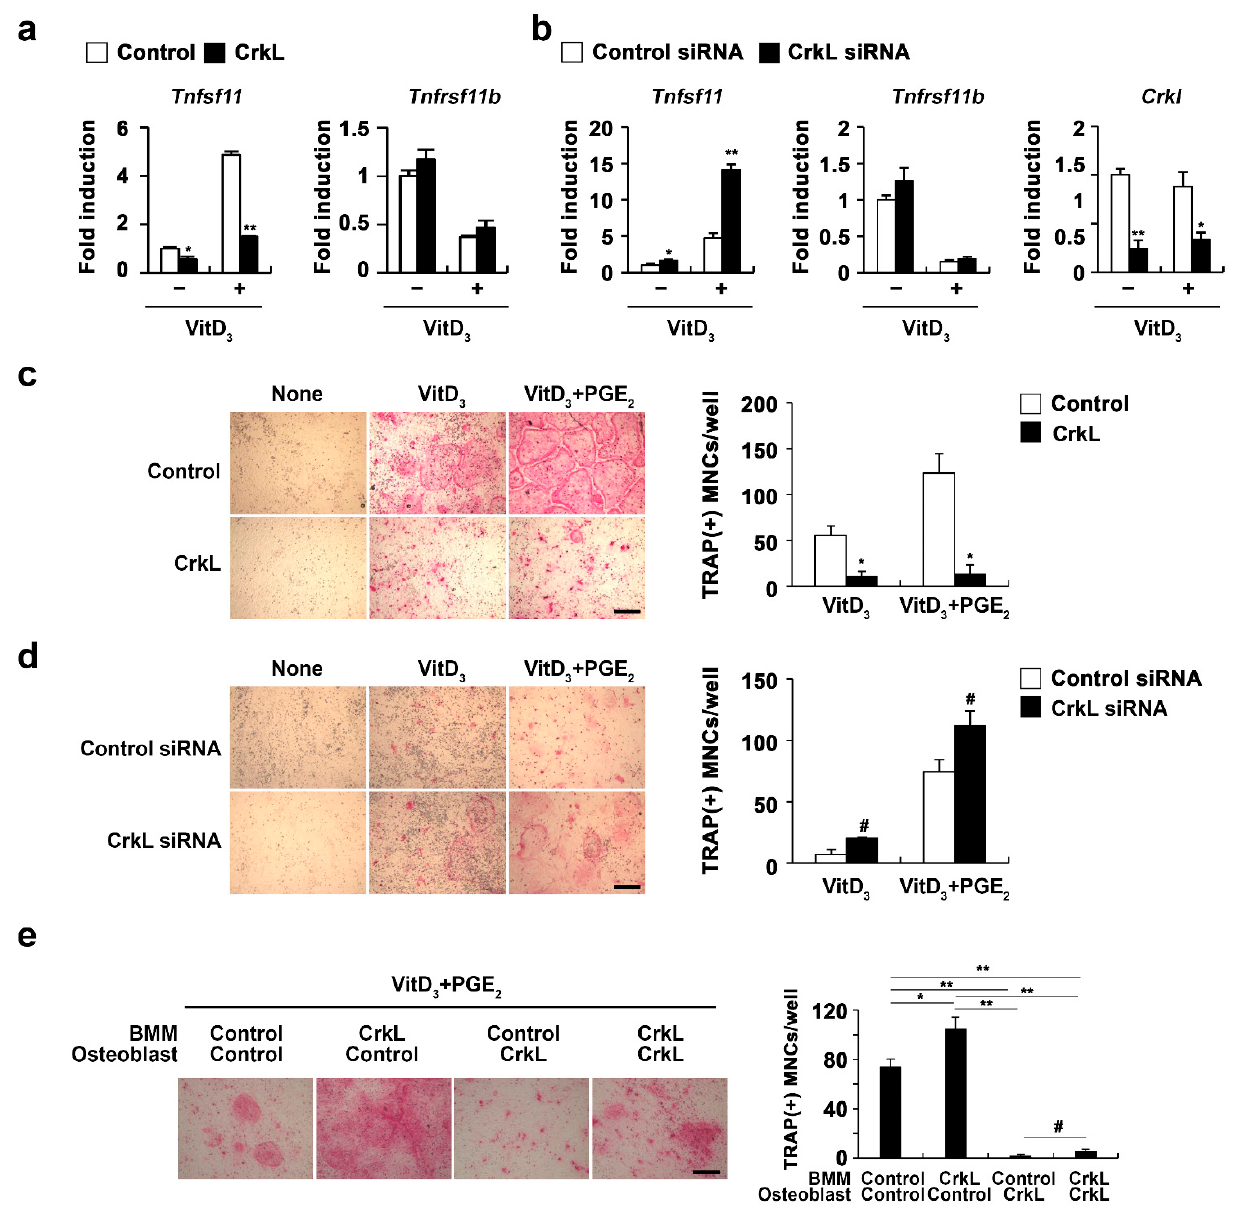
Figure 2. CrkL attenuates RANKL expression. ( a ) Primary osteoblast precursors overexpressing the control or CrkL retrovirus in the presence or absence of Vit D 3 . mRNA expression of the indicated genes. ( b ) Primary osteoblast precursors were transfected with control or CrkL siRNAs in the presence or absence of Vit D 3 . mRNA expression of the indicated genes was assessed by real-time PCR. ( c ) Primary osteoblast precursors overexpressing the control or CrkL retrovirus were cocultured with BMMs and Vit D 3 in the presence or absence of PGE 2 . TRAP staining images (left panel) where used to enumerate the number of TRAP-positive multinuclear cells (right panel). Bar: 200 µ m. ( d ) Primary osteoblast precursors transfected with control or CrkL siRNAs and cocultured with BMMs and Vit D 3 in the presence or absence of PGE 2 . TRAP staining images (left panel) where used to enumerate the number of TRAP-positive multinuclear cells (right panel). Bar: 200 µ m. ( e ) Osteoclast differentiation in BMMs, cocultured with osteoblasts, treated as indicated in the presence of Vit D 3 and PGE 2 . TRAP staining images (left panel) where used to enumerate the number of TRAP-positive multinuclear cells (right panel) in each sample. Bar: 200 µ m. # p < 0.05; * p < 0.01; ** p < 0.001 as compared with the